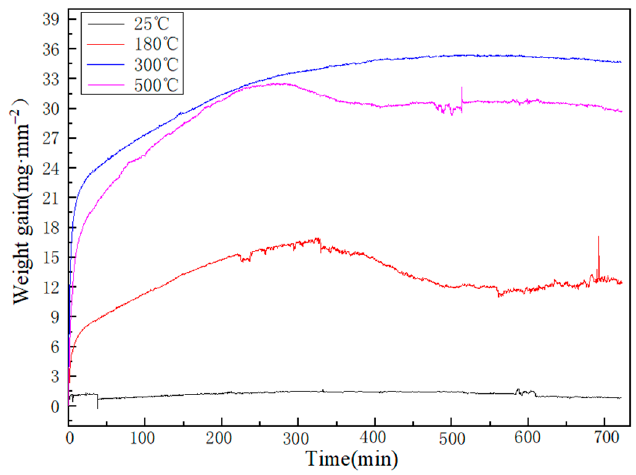
Figure 8. Oxidation kinetics curves of Al-Sn alloys at different temperatures.